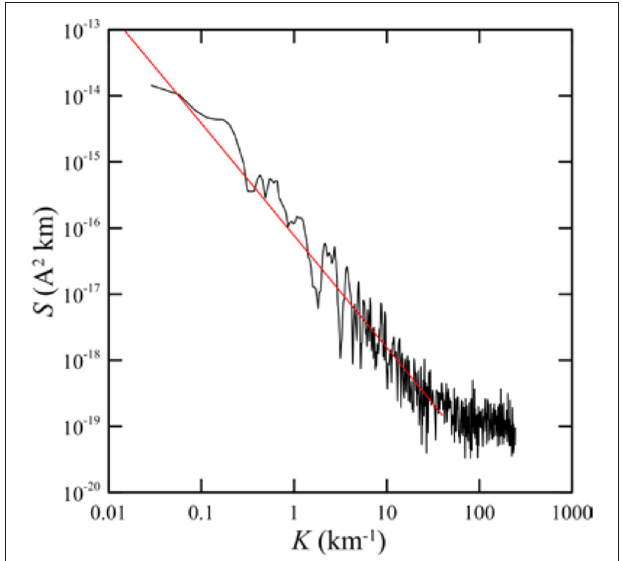
FIGURE 2 | Power spectral density, S , as a function of spatial frequency, K , for the lidar return from a depth of 10m across Barrow Canyon, Alaska. Red line is the K − 5 / 3 relationship characteristic of turbulent